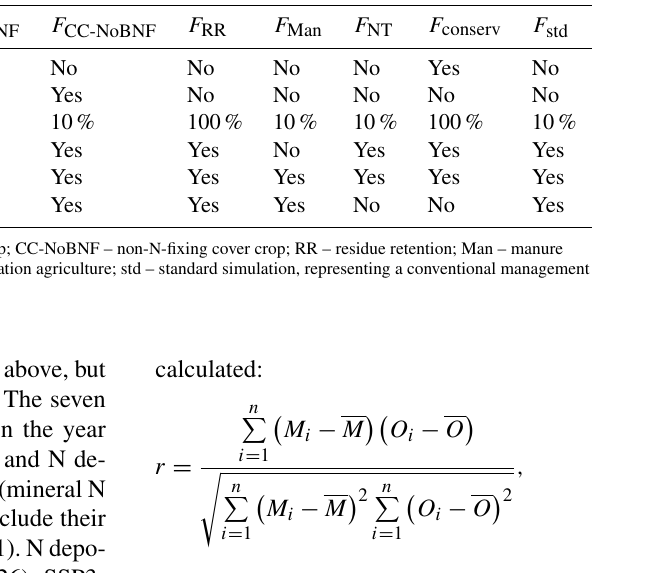
Table 3. Simulation setups used for comparison of SOC sequestration, crop yields, and cropland N losses with different managements over eastern Africa for historical and future runs (see Sect.